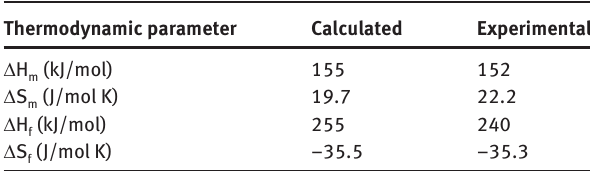
Table 1: Comparison of thermodynamic parameters of the formation and the mobility of point defects in metal-deficient nickel oxide, calculated from oxidation kinetics, on the background of the corresponding values determined experimentally from gravimetric and re-equilibration experiments.